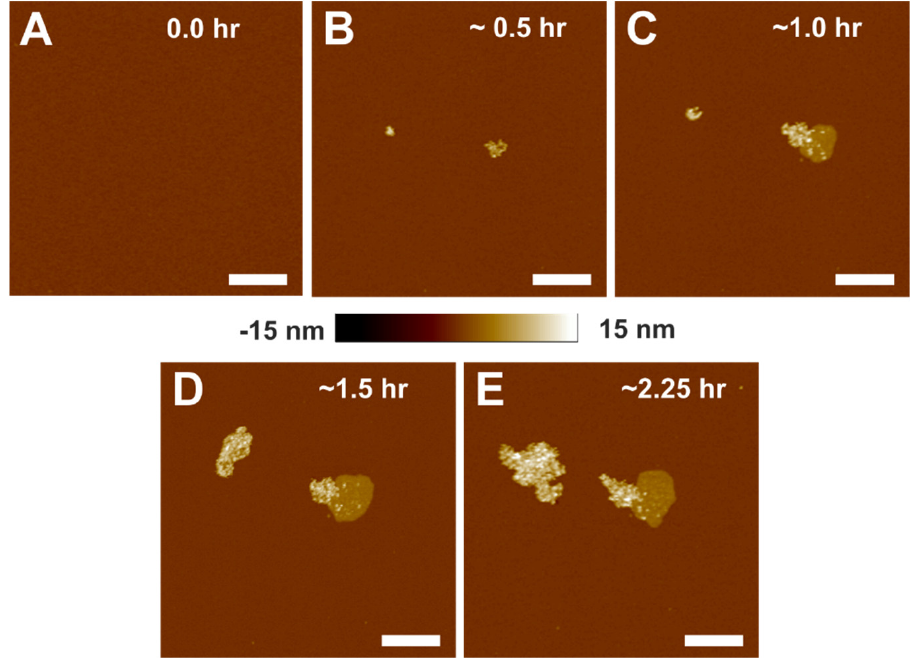
Figure 1. Topographical images of the interaction of α -crystallin with SLM with increasing incubation time. ( A ) The membrane before adding α -crystallin. ( B − E ) The membrane after adding α -crystallin, showing how the size of α -crystallin aggregates increases with time. As shown in ( C − E ), the intermediate complex formed, as represented by the intermediate height color, suggests a strong interaction of α -crystallin with the membrane. Image scale: 1 µm.